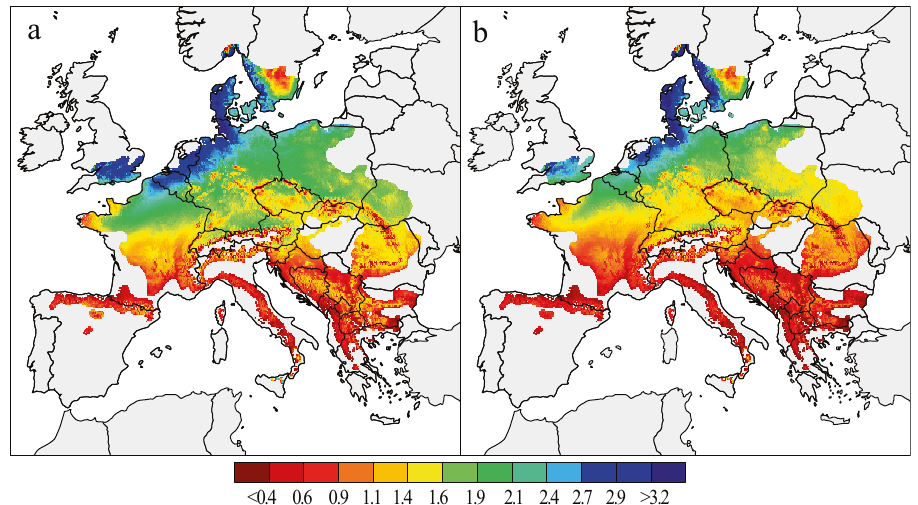
Fig. 2 Spatial patterns of beech growth during the last decades. Mean estimates of BAI (in mm 2 ) from 1955 – 1985 ( a ) and 1986 – 2016 ( b ), calculated for a theoretical tree derived from a 324-site chronology network.